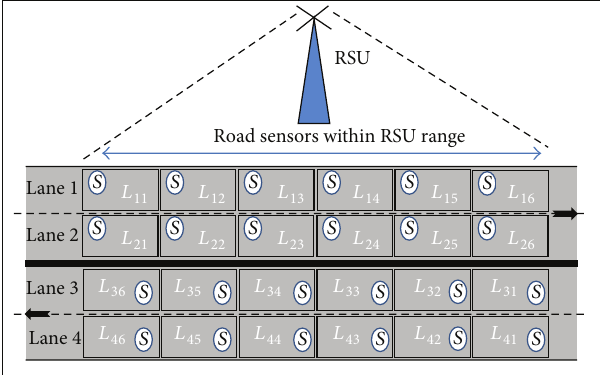
Figure 5: Organization of four-lane sensor grid